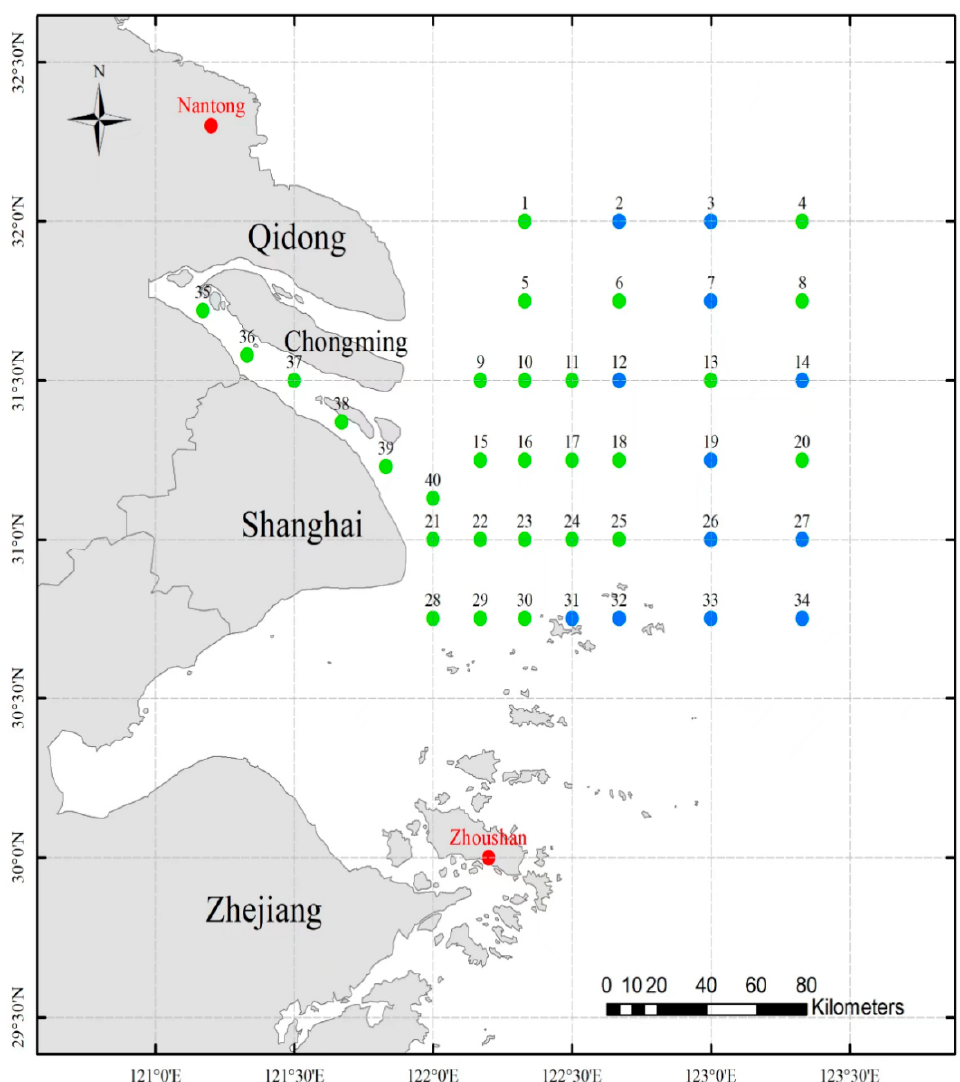
Figure 1. Sample localities of P. trituberculatus . crabs were collected from 13 sites of the Yangtze Estuary in wild. Blue and red circles indicate sampling sites for wild and cultivated crabs, respectively.